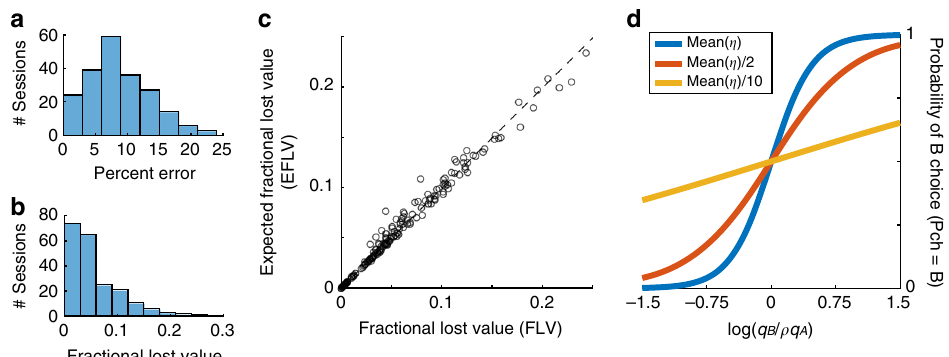
Fig. 10 Analysis of fractional lost value. a Distribution of percent errors across sessions. On average across sessions, mean(percent errors) = 8.7%. b Distribution of fractional lost value across sessions. On average across sessions, mean(FLV) = 0.054. c Expected vs. actual fractional lost value. Each data point represents one session. The expected fractional lost value (EFLV; y -axis) was almost identical to the fractional lost value (FLV; x -axis). On average across sessions, mean(EFLV) = 0.055. d Effects of decreasing the steepness of the sigmoid. The range on the x -axis is realistic for our experiments. The blue line is obtained with the mean sigmoid steepness measured in Exp.1 (mean( η )). The red and yellow lines were obtained by dividing mean( η ) by 2